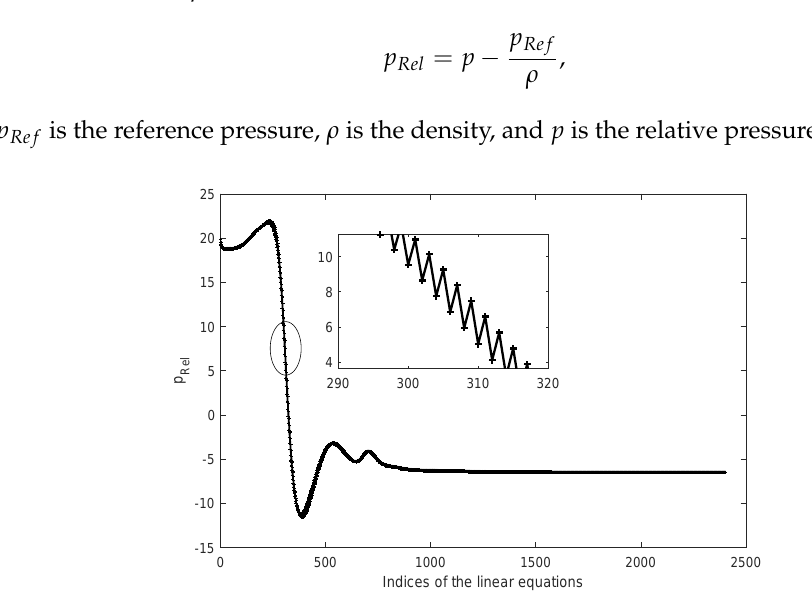
Figure 3. The illustration of the oscillatory field in the incompressible